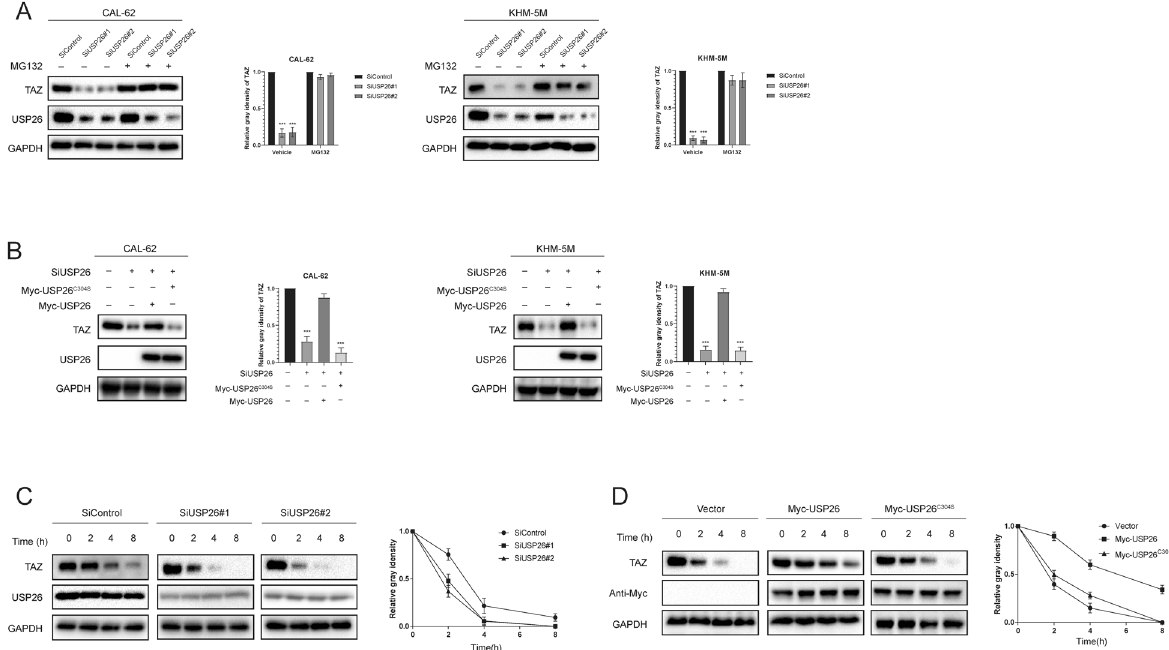
Fig. 3 USP26 increases TAZ stability. A In the presence of the proteasome inhibitor MG132, depletion of USP26 did not further decrease the TAZ protein level. ATC cells were transfected with siUSP26 or siControl. After 48 h, cells were treated with 10 µM MG132/vehicle for 6 h, cell lysates were prepared for western blot analysis. B ATC cells were transfected with USP26 (wild type or C304S) together with USP26 siRNA. The TAZ level were measured. C USP26 depletion decreased TAZ half-life in CAL-62 cells. CAL-62 cells were transfected with siUSP26 or siControl. After 48 h, cells were treated with 100 µM cycloheximide/vehicle for indicated times. Cell lysates were prepared for western blot analysis. D USP26 C304S did not increase TAZ half-life in HEK293 cells. HEK293 cells were transfected with Myc-tag, Myc-USP26 or Myc-USP26 C304S plasmids. After 24 h, cells were treated with 100 µM cycloheximide/vehicle for indicated times. Cell lysates were prepared for Western blot